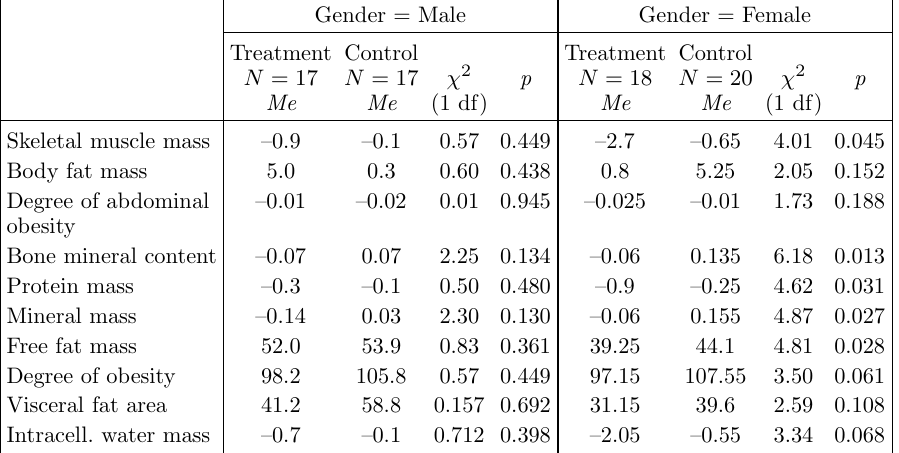
Table 5. Comparison of the variables describing the musculoskeletal system between treatment and control groups according to gender subgroups Gender = Male Gender = Female Treatment